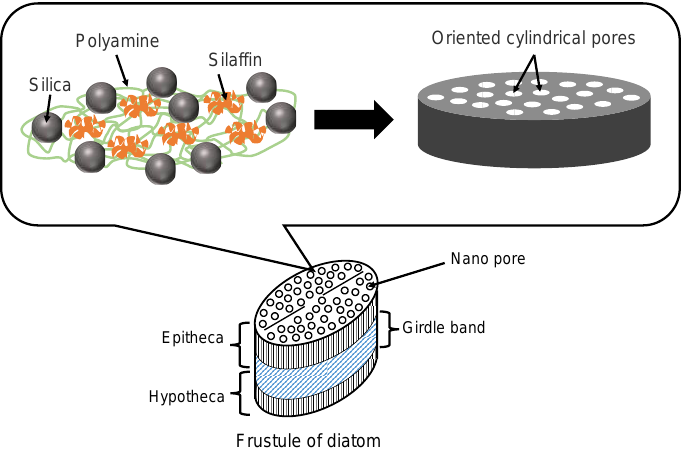
Figure 3. Illustration of diatom frustule structure and diatom proteins for silica precipitation.